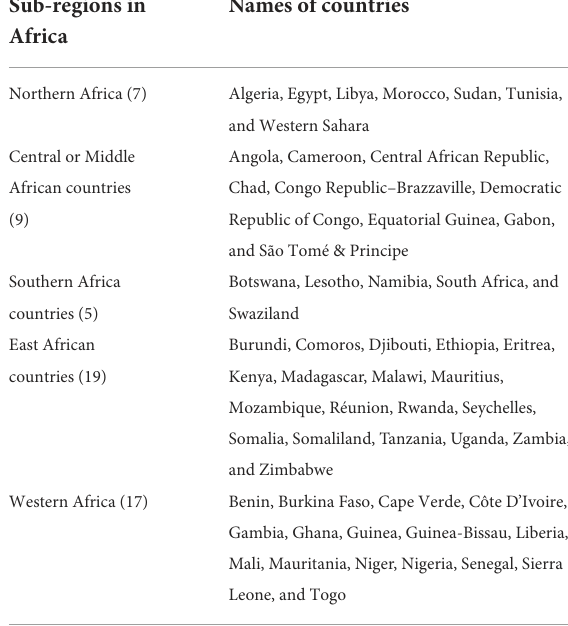
TABLE 1 The five sub-regions in Africa. Sub-regions